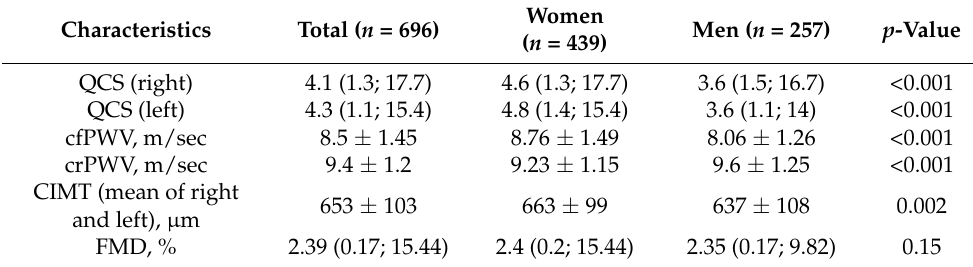
Table 2. Arterial parameters by